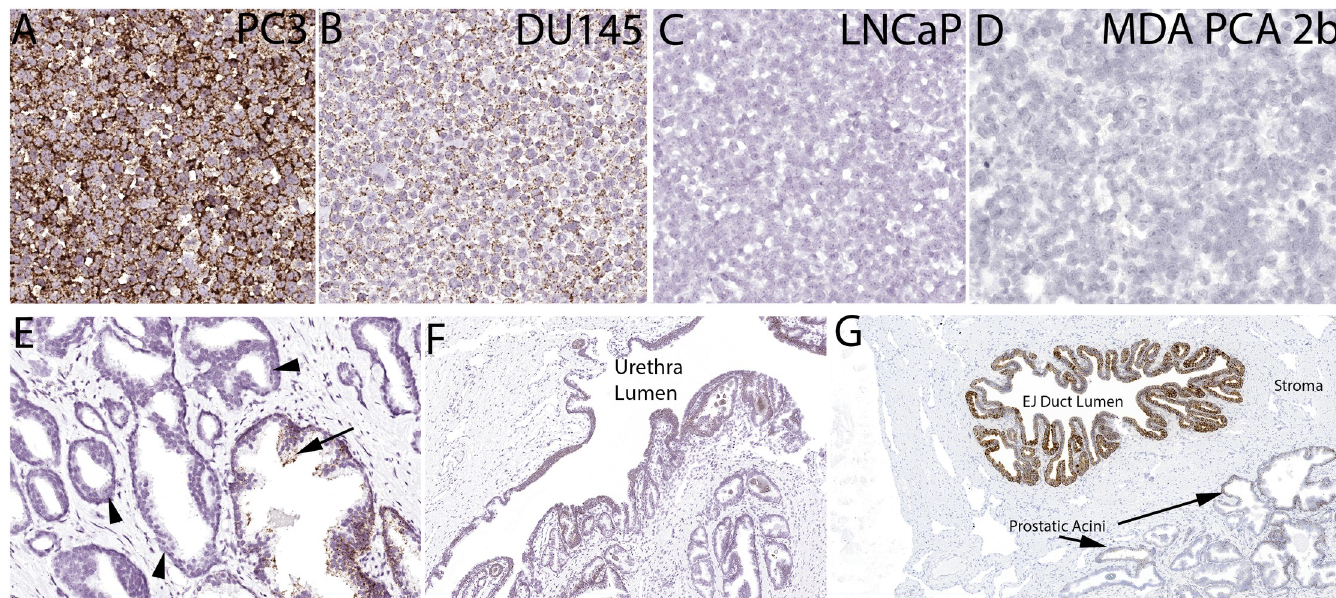
Fig 2. In situ hybridization for GSTP1 mRNA in cell lines (A-D) and benign prostate (E-G). EJ duct lumen indicates ejaculatory duct lumen.